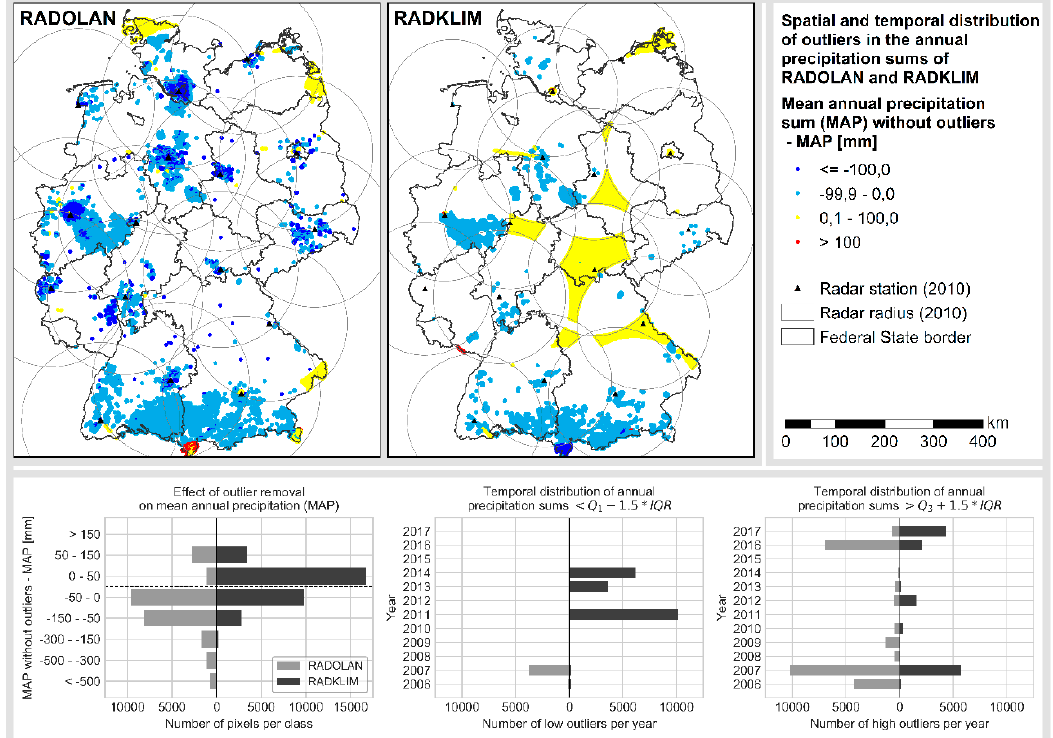
Figure 2. Spatiotemporal distribution of outliers in the annual precipitation sums of RADOLAN and RADKLIM. Blue values represent high outliers (MAP > cleaned MAP), yellow and red values represent low outliers (cleaned MAP > MAP).